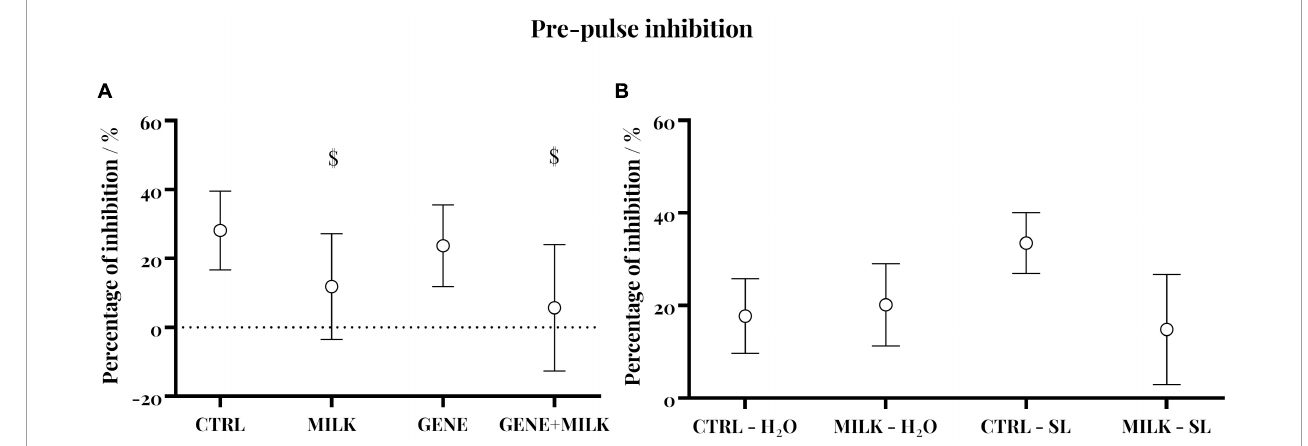
FIGURE4 Pre-pulse inhibition in experiment 1 (A) and experiment 2 (B) : Percent inhibition of the startle reflex measured as PPI = [(A–B)/A × 100]: In panel (A) is the Galvanic reflex in response to the startle stimulus alone, and in panel (B) is the response to pre-pulse plus pulse stimuli (circular symbol) with 95% CI (whiskers). $ indicate that experimental groups did not differ from the chance level.